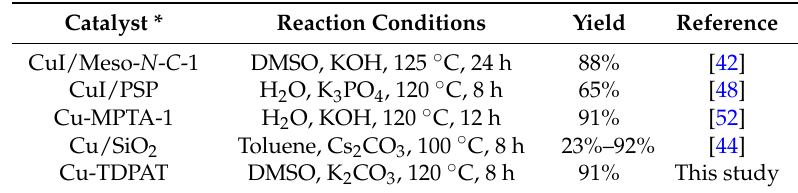
Table 3. Comparison of activity of different heterogeneous catalysts in the N -arylation reaction of imidazole and